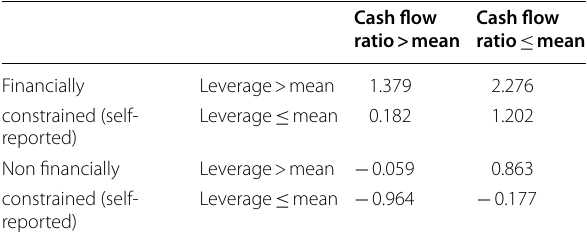
Table 2 Average values of the financing constraints index FC. By level of leverage, cash flow to assets ratio and self-reported financial constraints (AC).